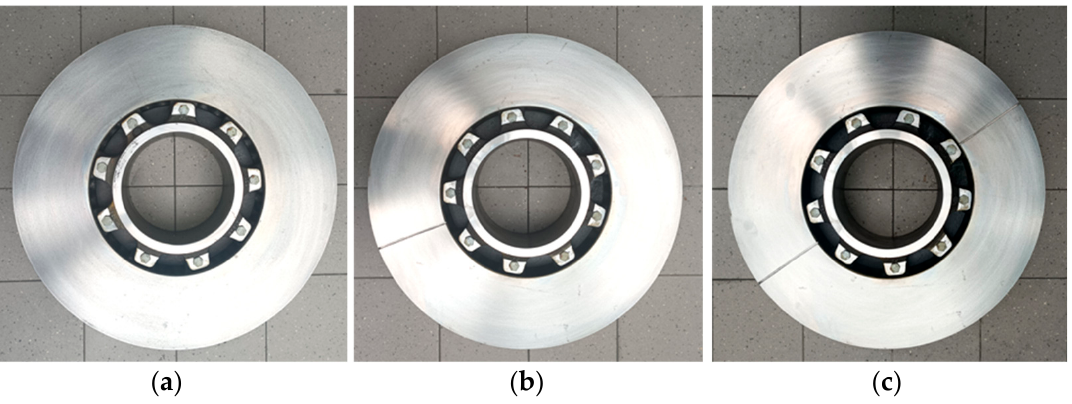
Figure 3. View of the brake discs used during testing: ( a ) 610 × 110 type disc without notch, ( b ) 610 × 110 type disc with one notch, ( c ) 610 × 110 type disc with two notches.